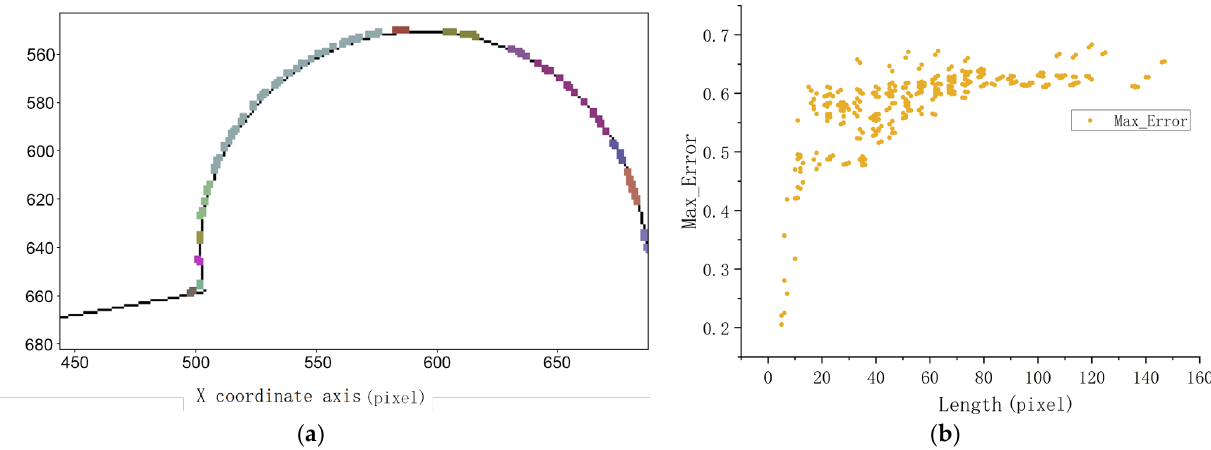
Figure 16. ( a ) l 8 distribution of point group. ( b ) Distribution of the length of the fitted contour segment in relation to the fitting